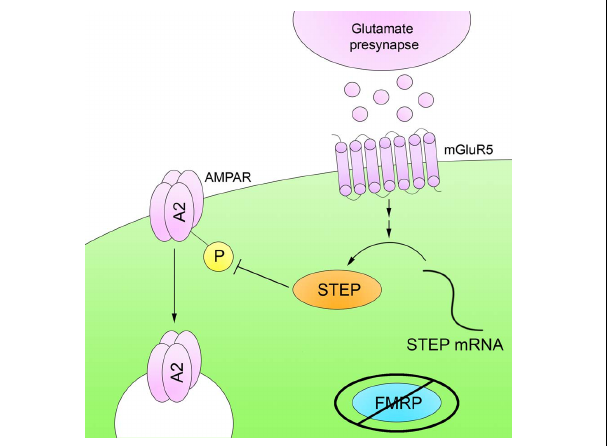
FIGURE 5 | Striatal-enriched protein tyrosine phosphatase and fragile X syndrome. FMRP is an RNA-binding protein that represses mRNA translation in dendrites. FMRP is absent in FXS, and as a result there is a disruption in mRNA translation. STEP mRNA associates with FMRP, and STEP protein levels are increased in Fmr1 KO mice.The higher levels of active STEP protein are thought to disrupt synaptic function by dephosphorylation of STEP